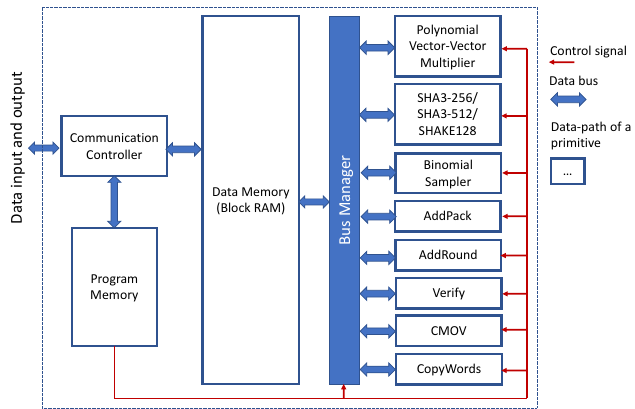
Figure 1: Block diagram: Instruction-set architecture for